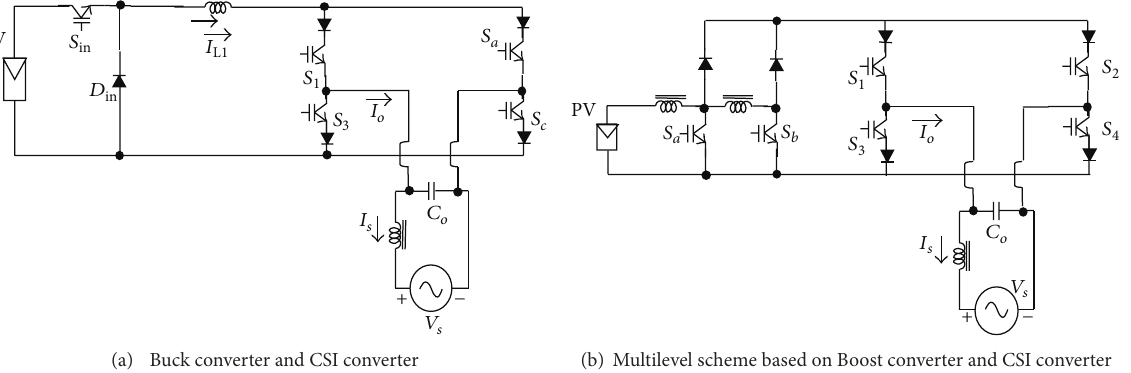
Figure 2: Topologies to inject current to the ac mains based on